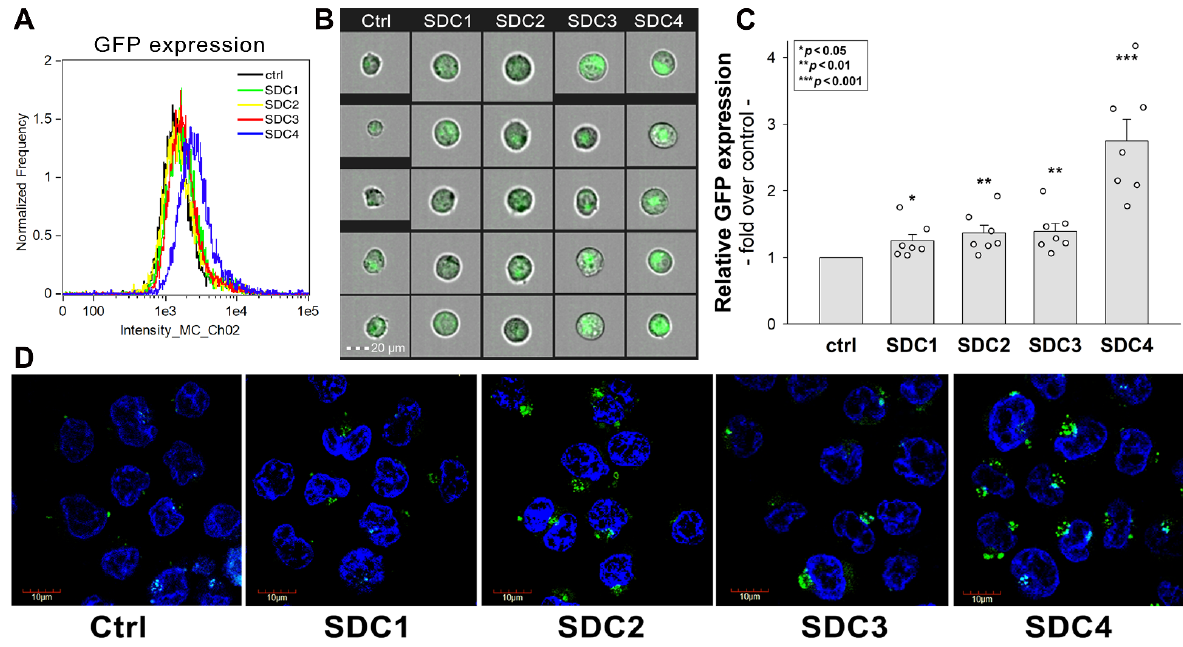
Figure 3. AAV9-mediated GFP transduction into SDC transfectants. WT K562 cells and SDC